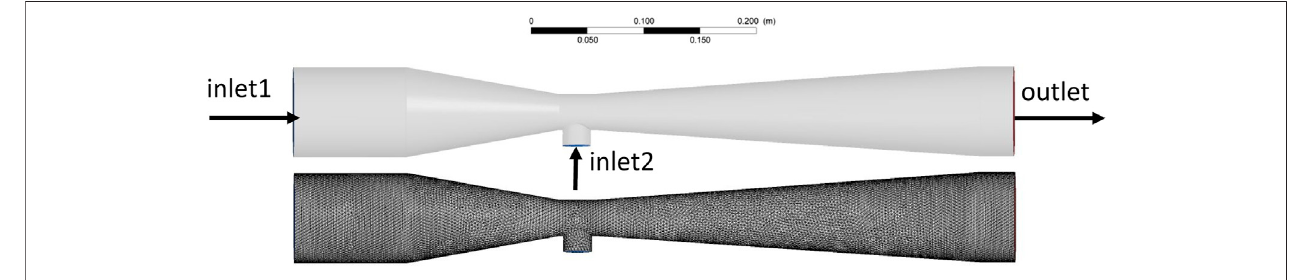
FIGURE 2 | Geometric models and mesh generation.